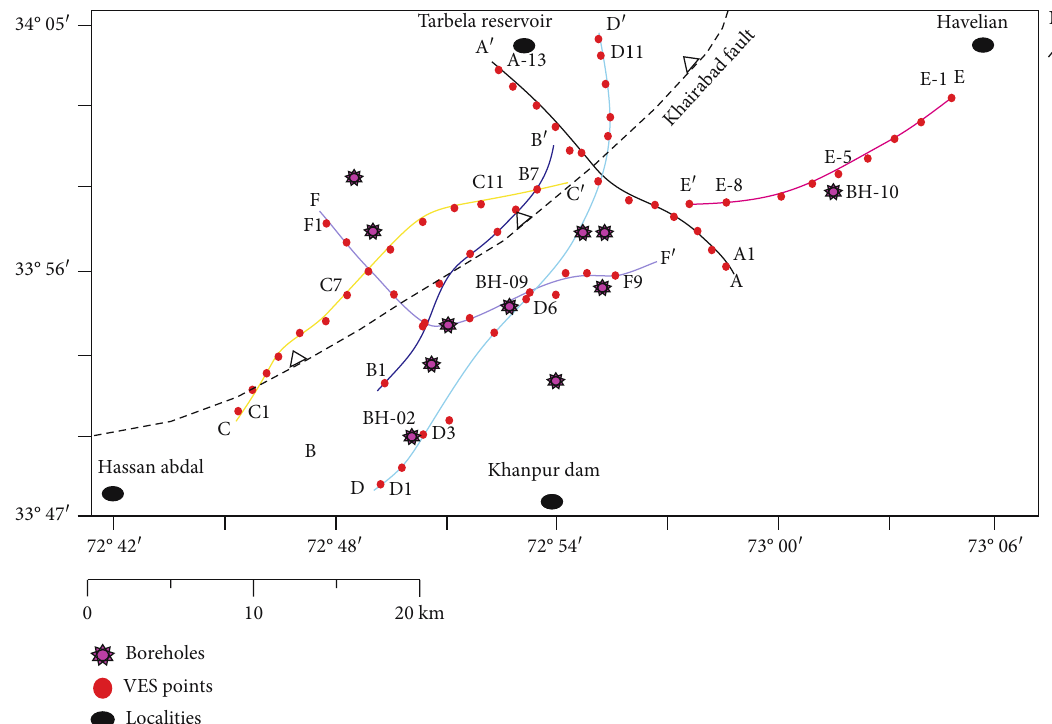
Figure 3: Location of the boreholes, VES points, and subsurface cross-sections are highlighted on the base map of the study area. A total of six subsurface cross-sections (A-A ’ , B-B ’ , C-C ’ , D-D ’ , E-E ’ , and F-F ’ ) were generated utilizing these datasets and presented in Figure